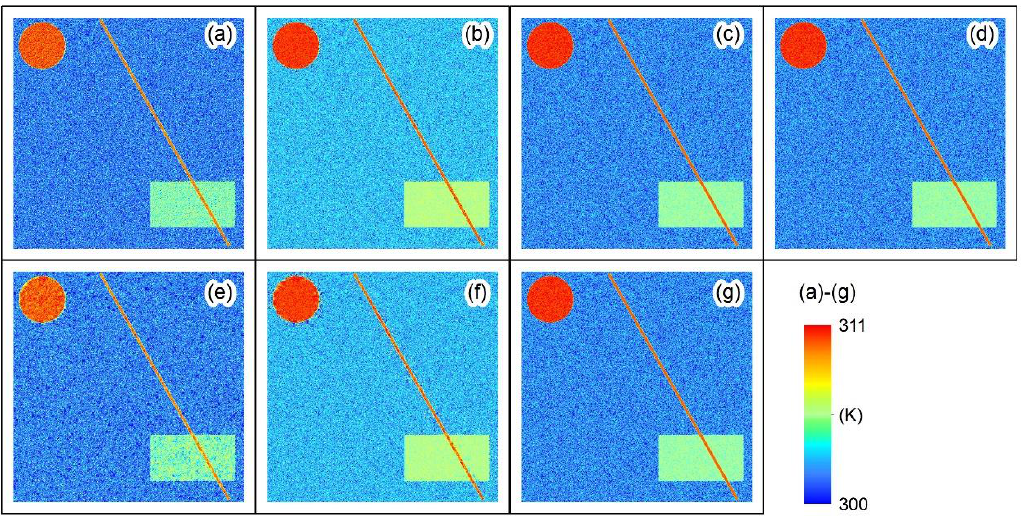
Figure 9. Results of DLST based on the simulated data. ( a ) GWS (40 m → 10 m); ( b ) LWS (40 m → 10 m); ( c ) OWS (40 m → 10 m); ( d ) simulated LST; ( e ) GWS (100 m → 10 m); ( f ) LWS (100 m → 10 m); ( g ) OWS (100 m → 10 m).